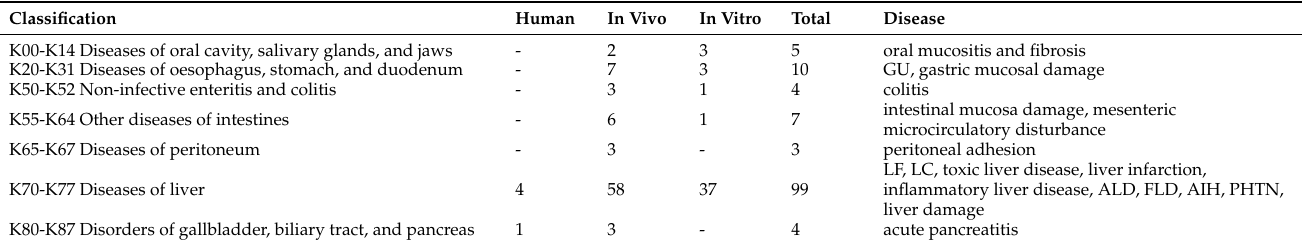
Table 5. The statistics of pharmacological results and its major diseases of SMC by experimental type in XI Diseases of the digestive system of